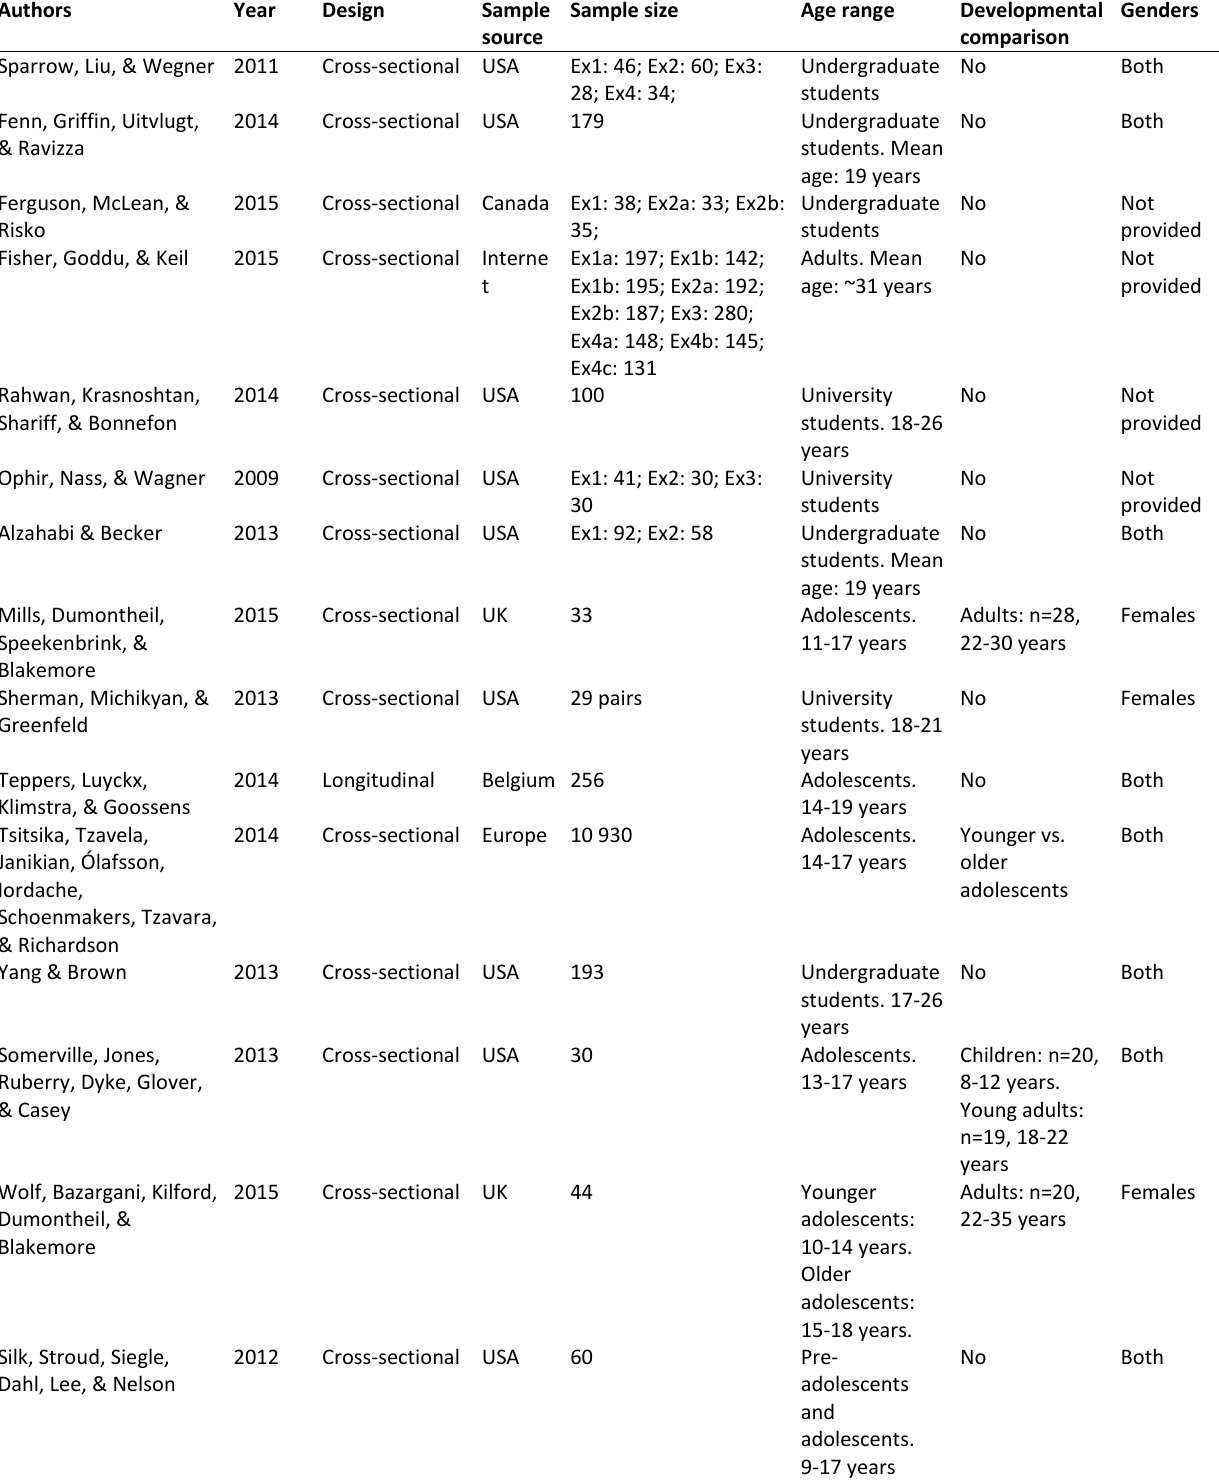
Table 1. Information for the studies included in this